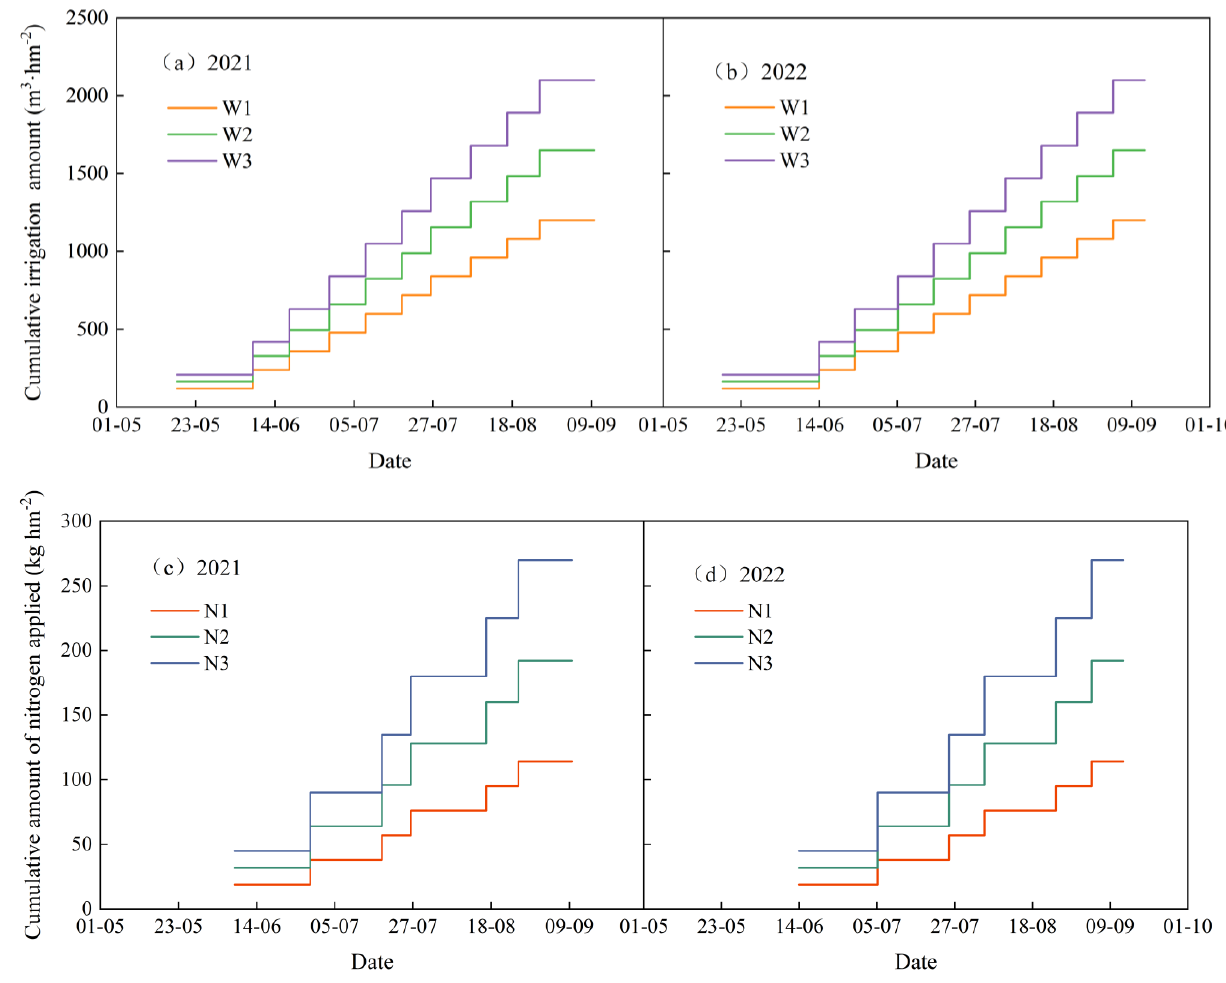
Figure 3. N accumulation with each application and irrigation treatment during potato fertility. Table 1. Allocation ratio of the irrigation and N applications during the potato fertility